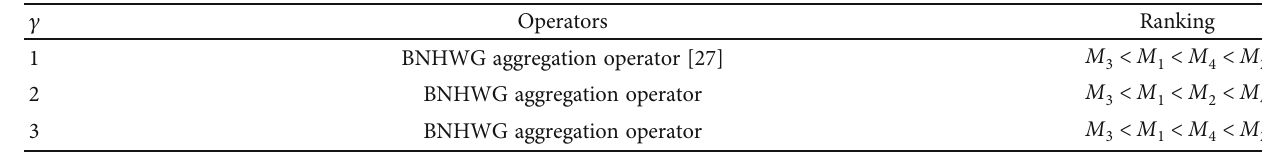
Table 5: Ranking for all